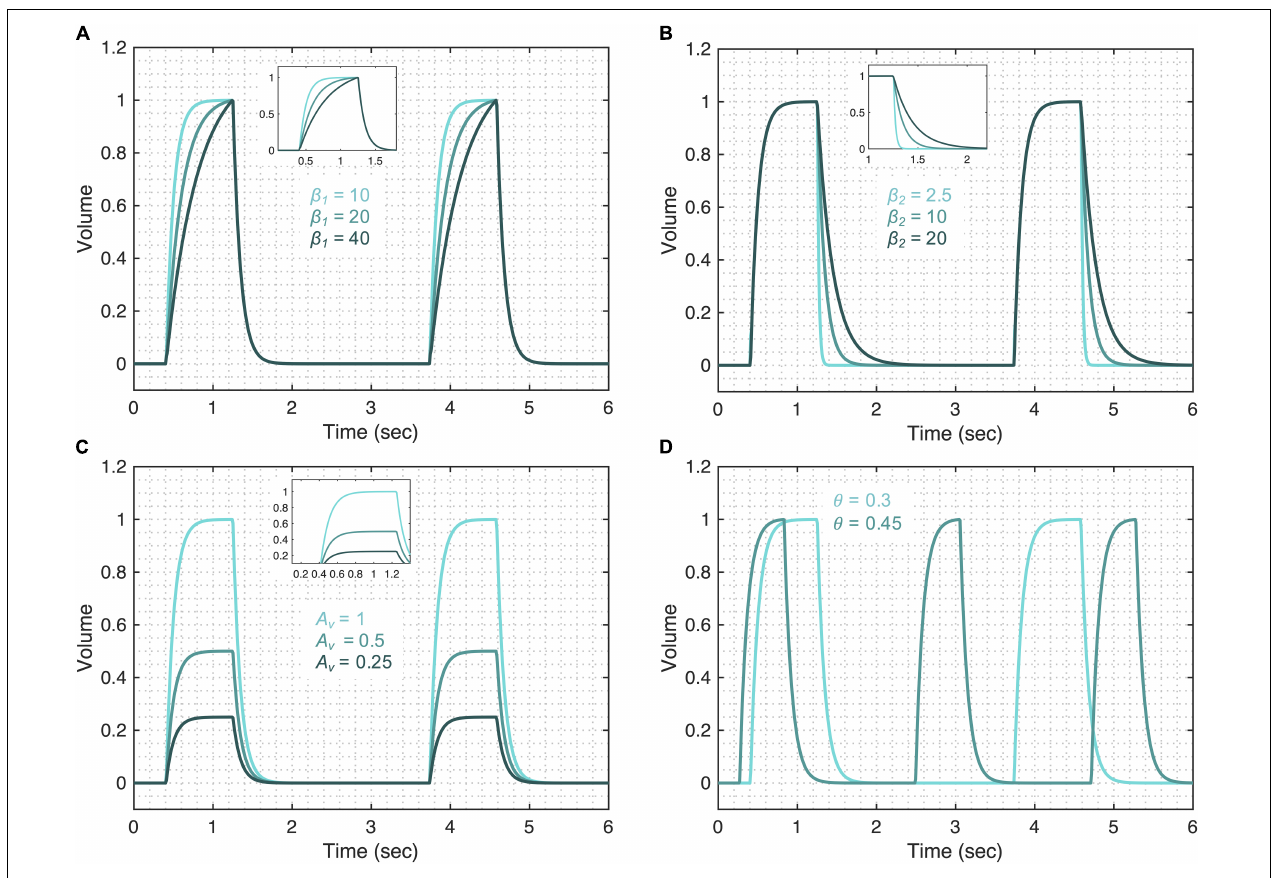
FIGURE 3 | Demonstrating the volume model flexibility by varying parameters that alter characteristic features of the volume waveform. The gradient of the rising and falling signals can be altered using the (A) β 1 and (B) β 2 parameters, respectively. Increased values of these parameters increase the transient time for the signal to reach the same volume level. (C) The amplitude of the waveform can be altered using the parameter A v . (D) Changes in the respiratory frequency ( θ ) change the period of the breath. The output of the model ( V ) was calculated using Eqs 1–5 while considering θ = 0.3, a 1 = 200, b 1 = 0.7, φ 1 = 0, β 1 = 30, β 2 = 10, and A v = 1. The respective variation in the functions that make the volume model is shown in Supplementary Figure 1 for each case. Note that the model variability shown here is independent of the ventilator